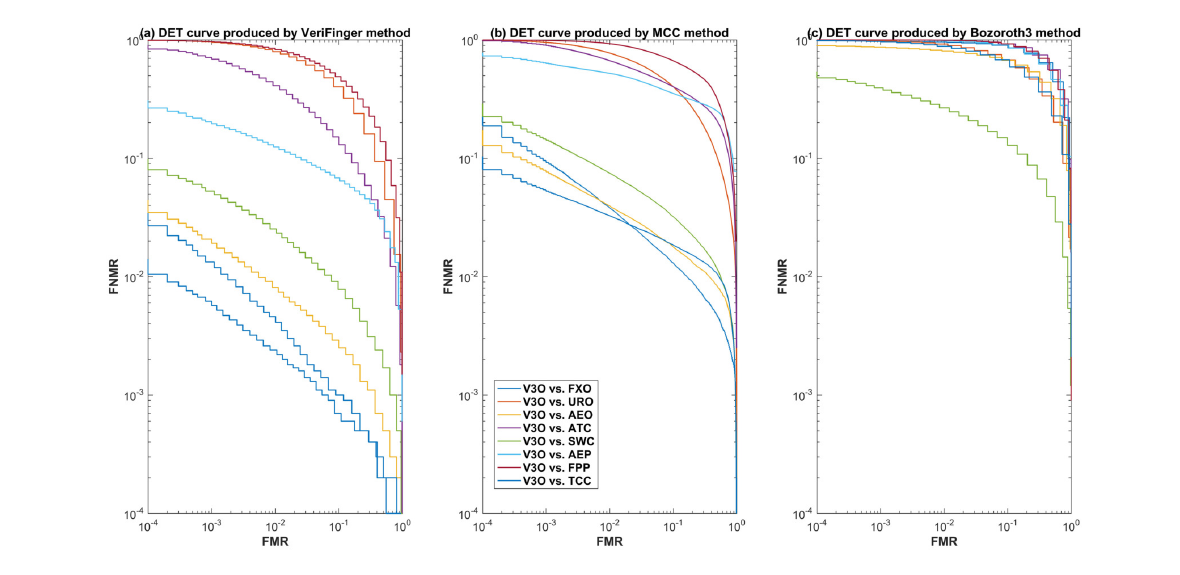
Figure 8. DET curves of the three methods when V3O is used as a gallery